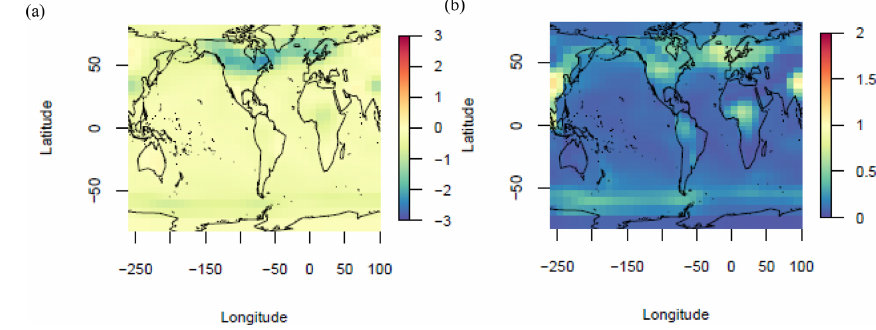
Figure 7. LGM change in precipitation rate (mmd − 1 ) ENS 104 mean (a) and standard deviation (b)